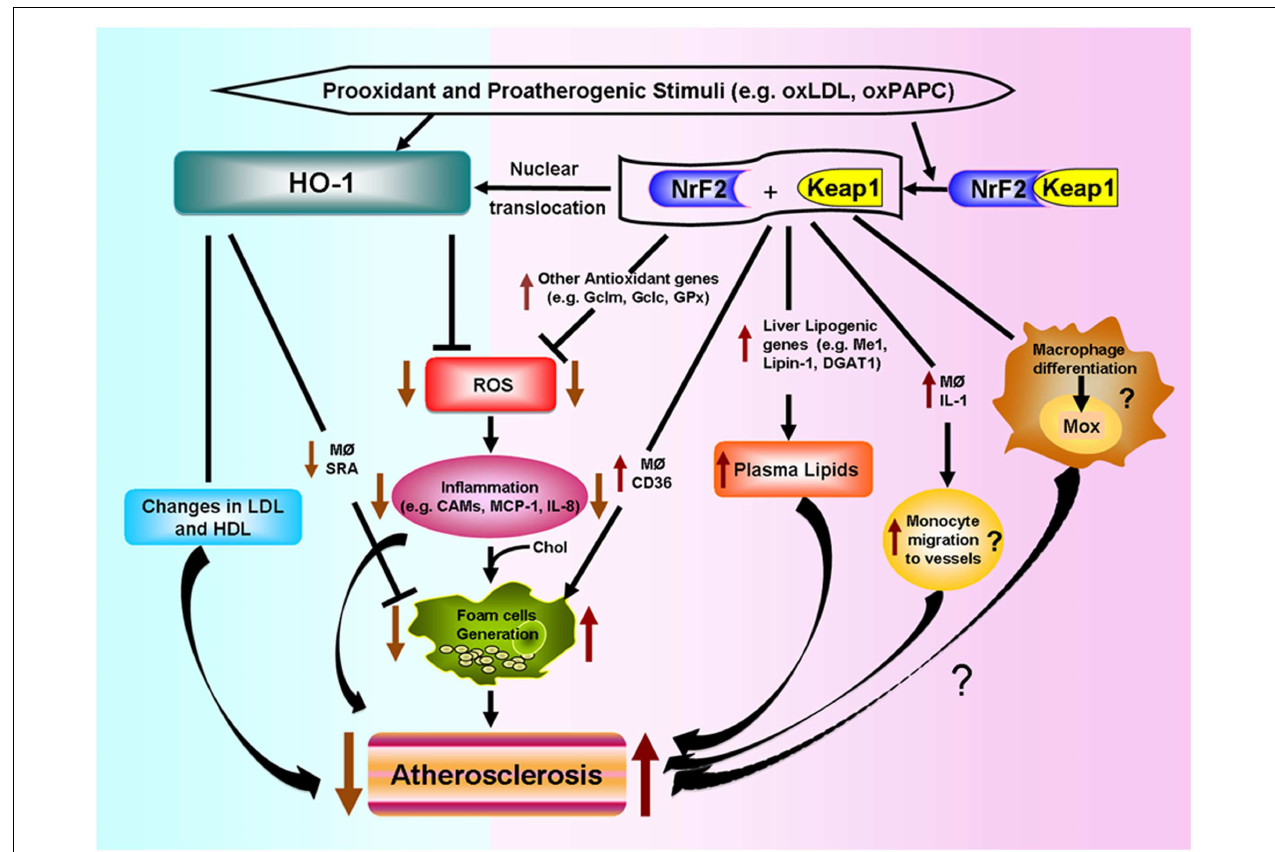
agents lead to dissociation of the Nrf2-Keap1 complex, with release of Nrf2 and nuclear translocation that leads to the induction of HO-1 and several other antioxidant genes that result in decreased ROS formation. However, Nrf2 expression promotes atherosclerotic lesion development. Possible mechanisms include: (1) increased macrophage lipid uptake and foam cell formation, (2) increased lipogenesis and greater levels of non-HDL plasma cholesterol, (3) greater macrophage secretion of IL-1 and monocyte migration to the vessels, and (4) possible macrophage differentiation into a proatherosclerotic